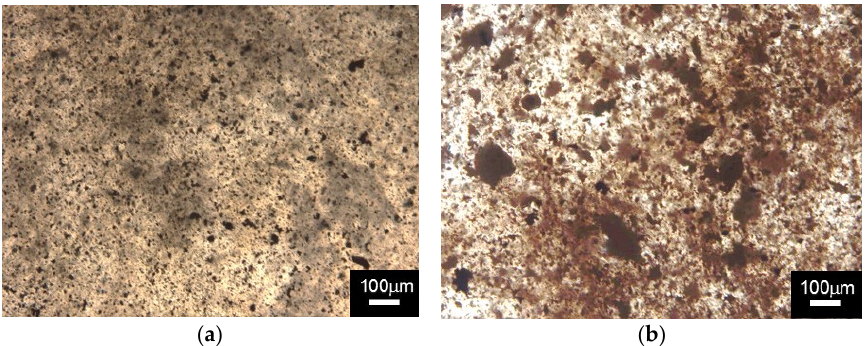
Figure 9. Optical Microscopy of the films produced from mechanically alloyed powders for 4 h. This is ( a ) PVA + 2.5% wt. Ag and ( b ) PVA + 10% wt. Ag. is ( a ) PVA + 2.5% wt. Ag and ( b ) PVA + 10% wt. Ag.